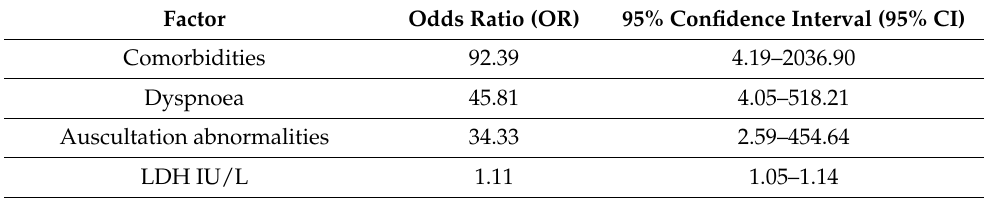
Table 3. Logistic regression analysis for risk factors for the necessity of oxygen